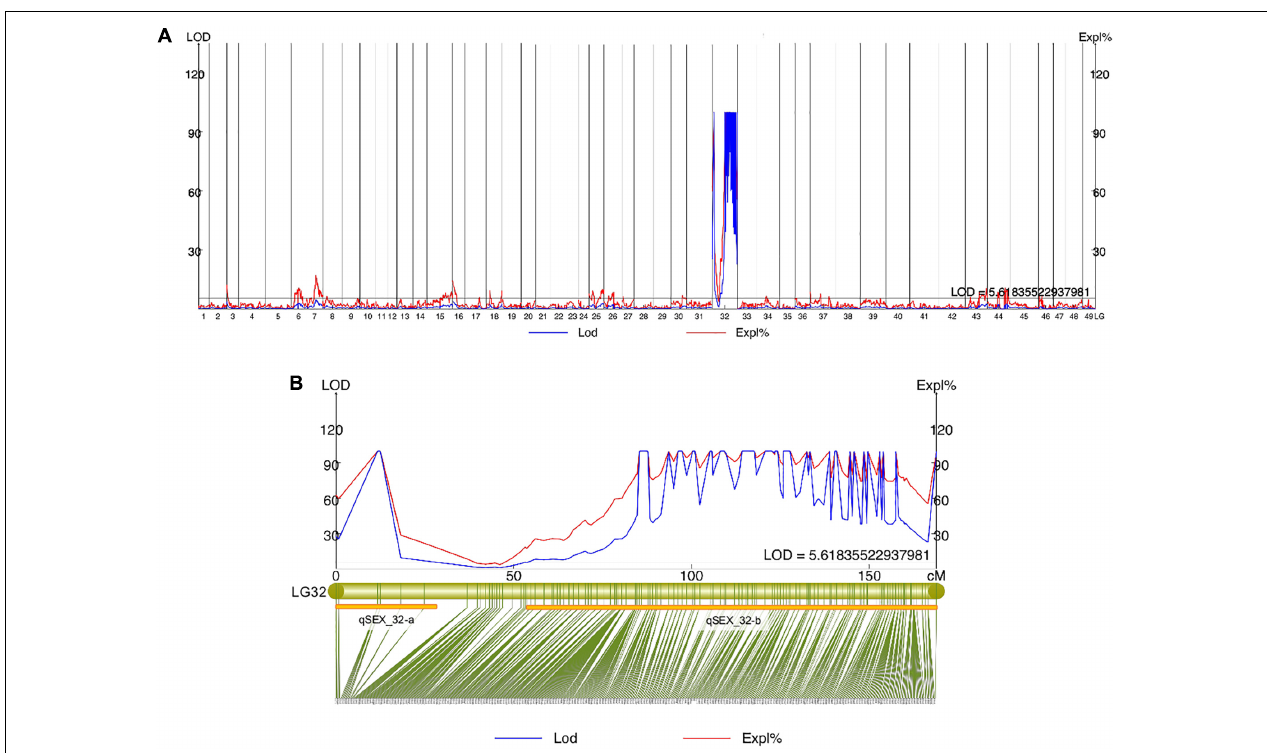
FIGURE 2 | (A) Sex QTL mapping and association analysis in Scylla paramamosain in all linkage groups. (B) The location of two QTLs (qSEX_32-a and qSEX_32-b) on LG32, their corresponding LOD and PVE values, and their respective markers. All eight female-specific SNP markers were in qSEX_32-b.